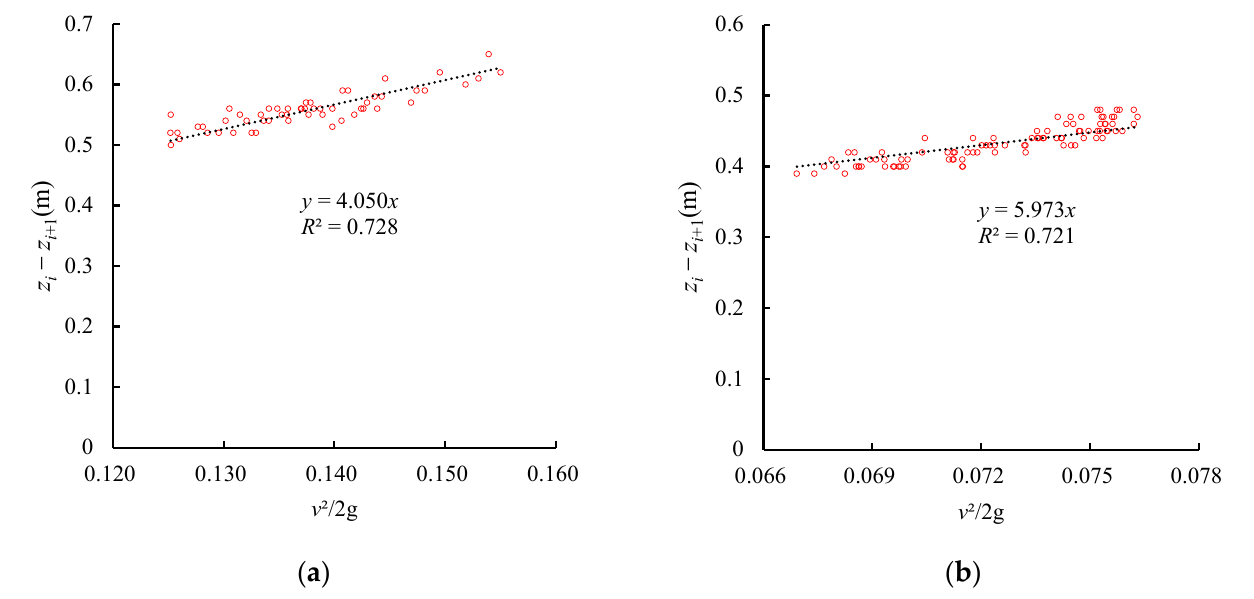
Figure 5. Relationship between z i − z i +1 and v 2 /2 g for structures: ( a ) an inverted siphon of the Baihe River and ( b ) an aqueduct of the Caohe River.